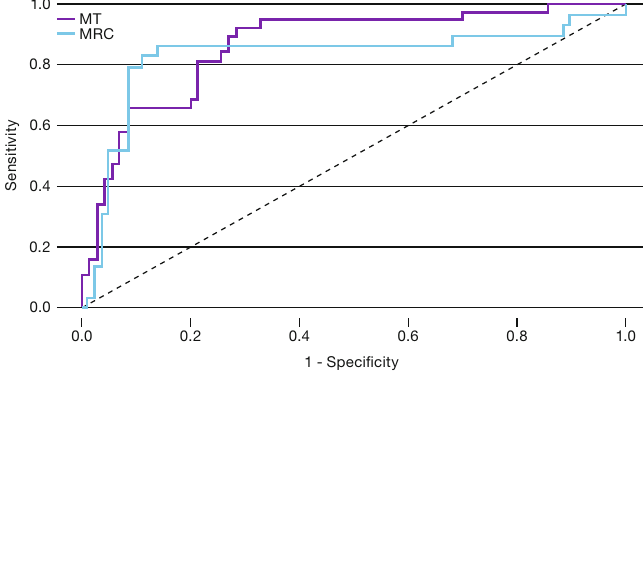
Figure 2: ROC curve for detection of MT and